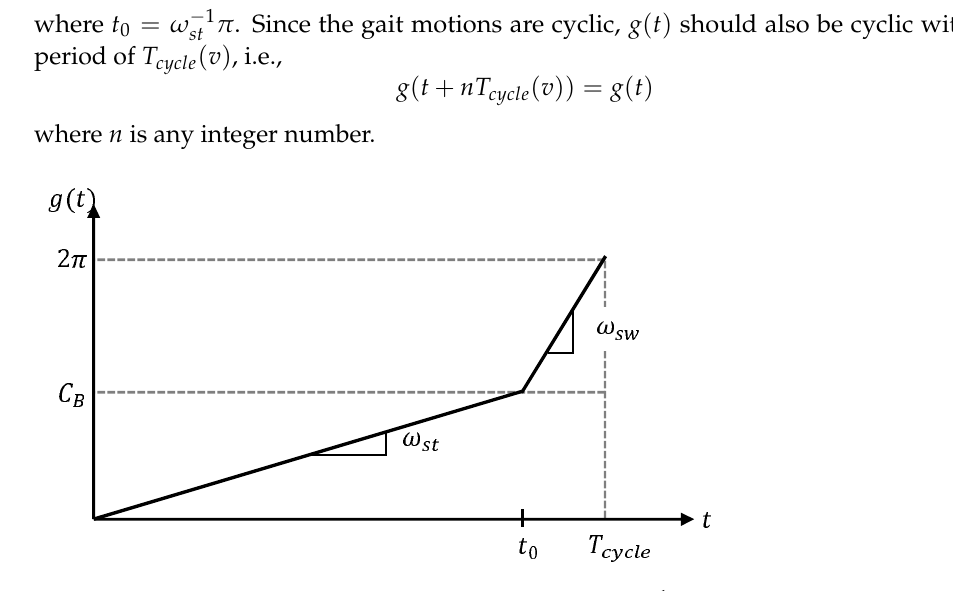
π , ω sw and ω st are the rates in the st